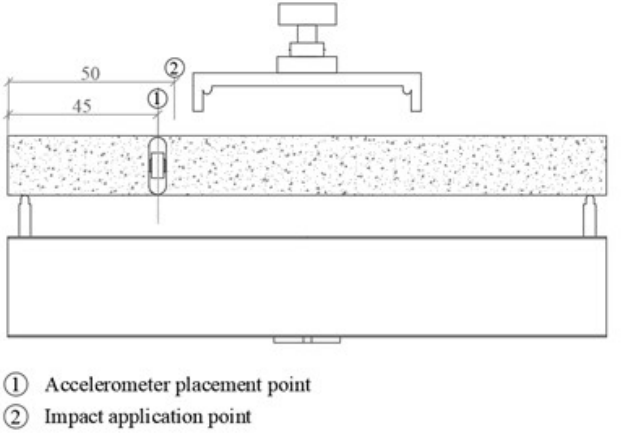
Figure 11. Accelerometer placement and impact application point in the vibration